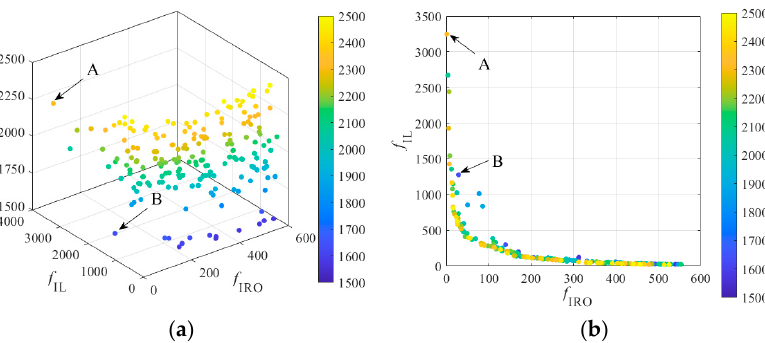
Figure 5. The optimal solutions of the CCO-type IPT system. ( a ) 3D diagram; ( b ) 2D diagram.